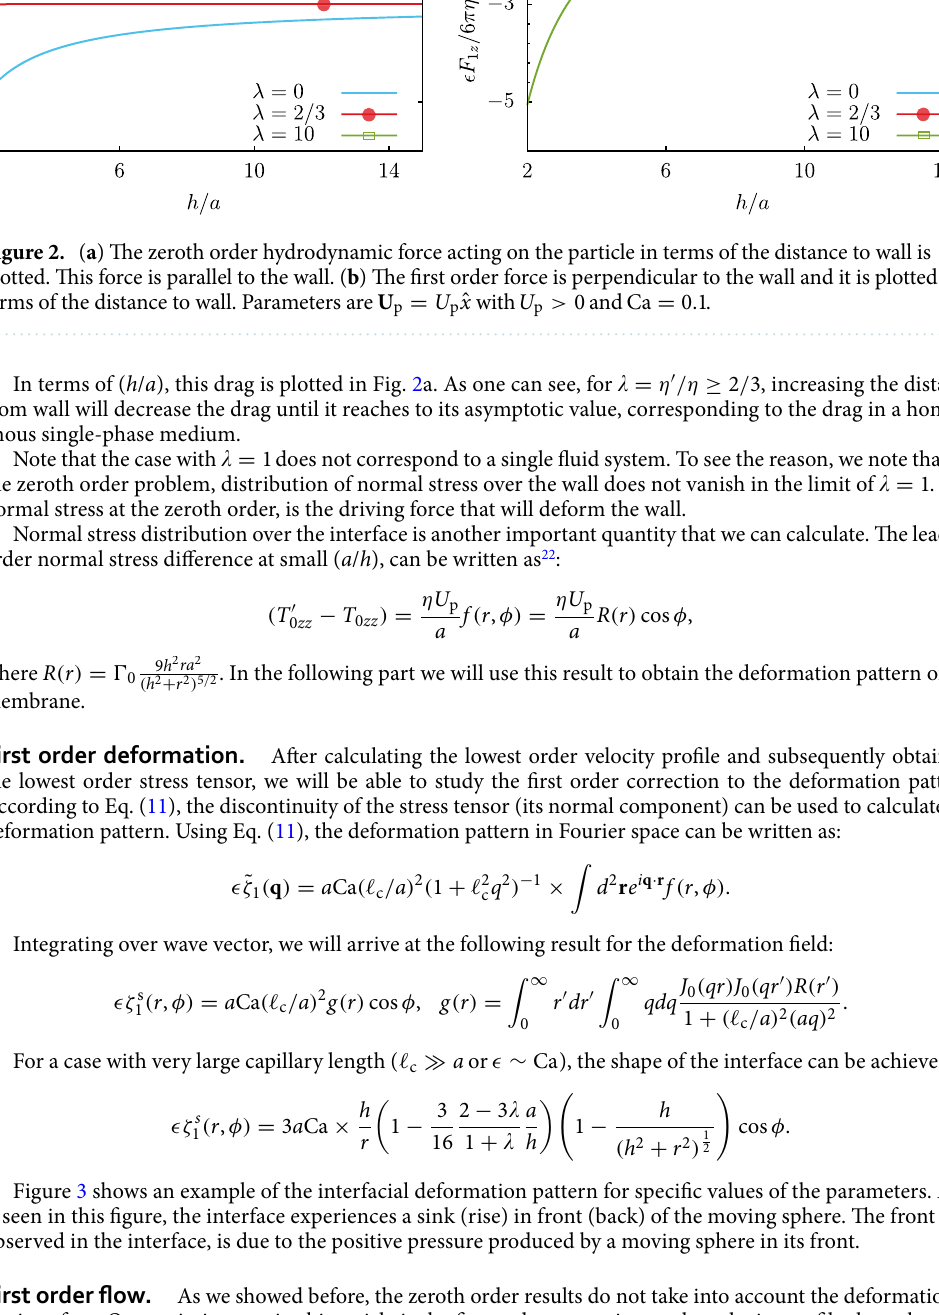
0.1 U p x with U p > 0 and Ca = ˆ =